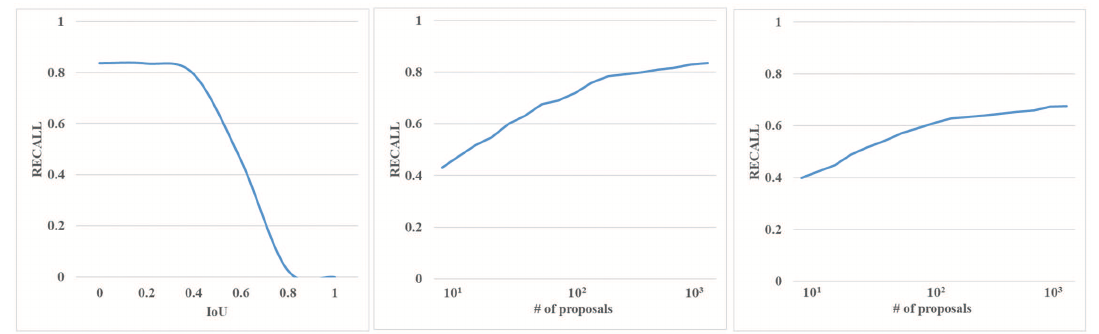
Figure 7. From left to right: recall vs. IoU; and recall vs. proposals at IoU threshold of 0.25 and 0.5.